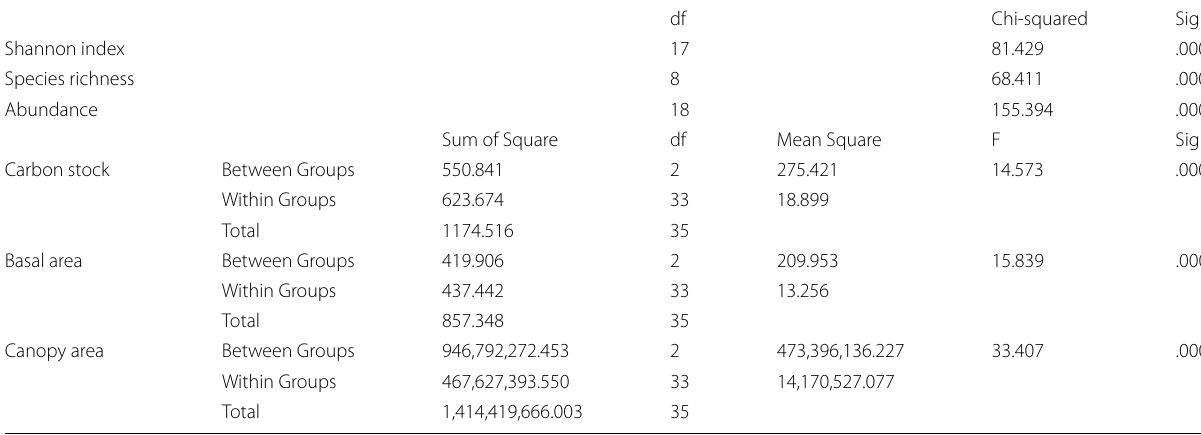
Table 1 Generalized linear model (glm) for Shannon–Weaver index values, specific richness, abundance, and analysis of variance (ANOVA) of one factor (area) was performed for carbon stock, basal area and canopy area